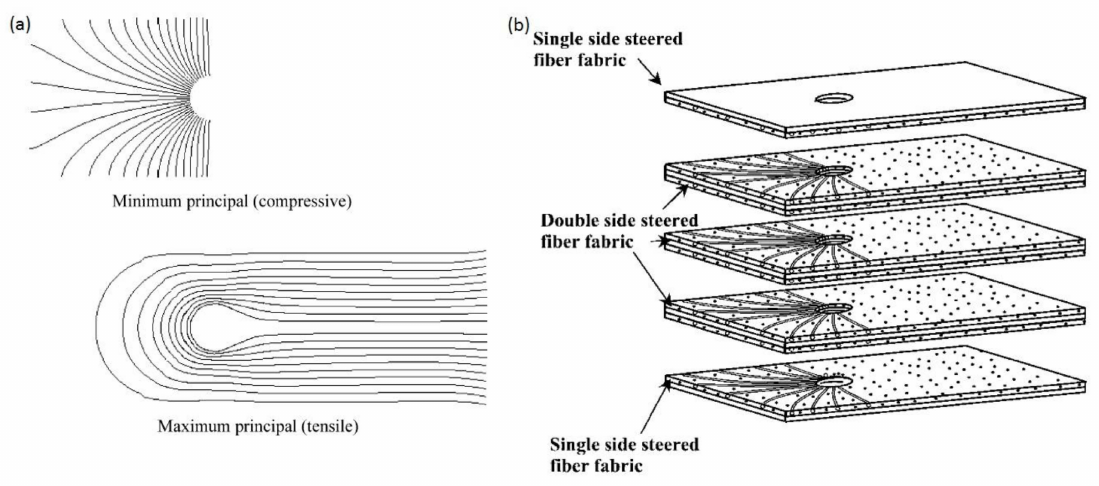
Figure 20. ( a ) Principal stress trajectories of a pin loaded laminate, ( b ) Typical lay-up of steered fibre samples